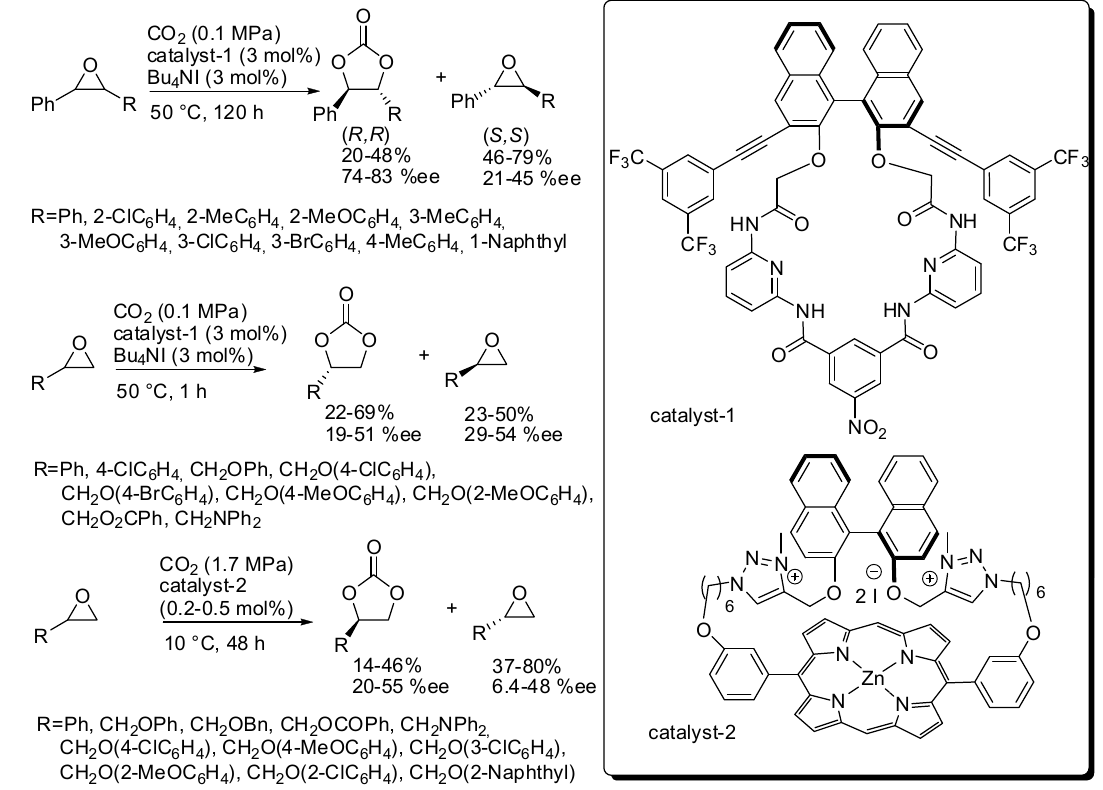
Scheme 7. Kinetic resolution of epoxides with organocatalyst.